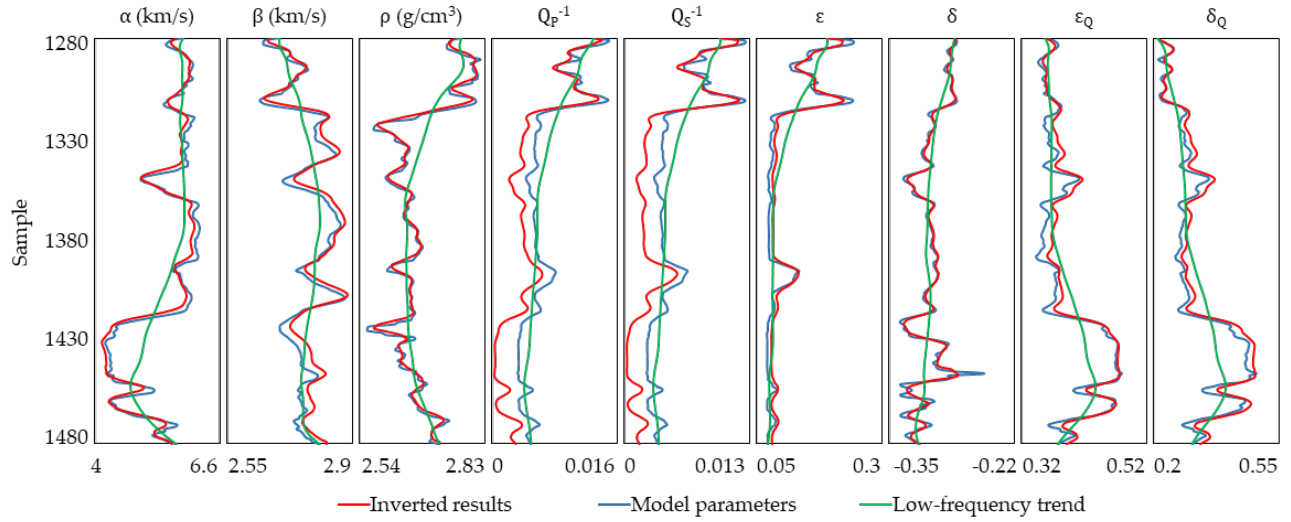
Figure 10. Comparison of the inverted results and true values of the P- and S-wave velocity, density, inverse quality factors, anisotropic parameters and Thomsen-style attenuated anisotropic parameters.